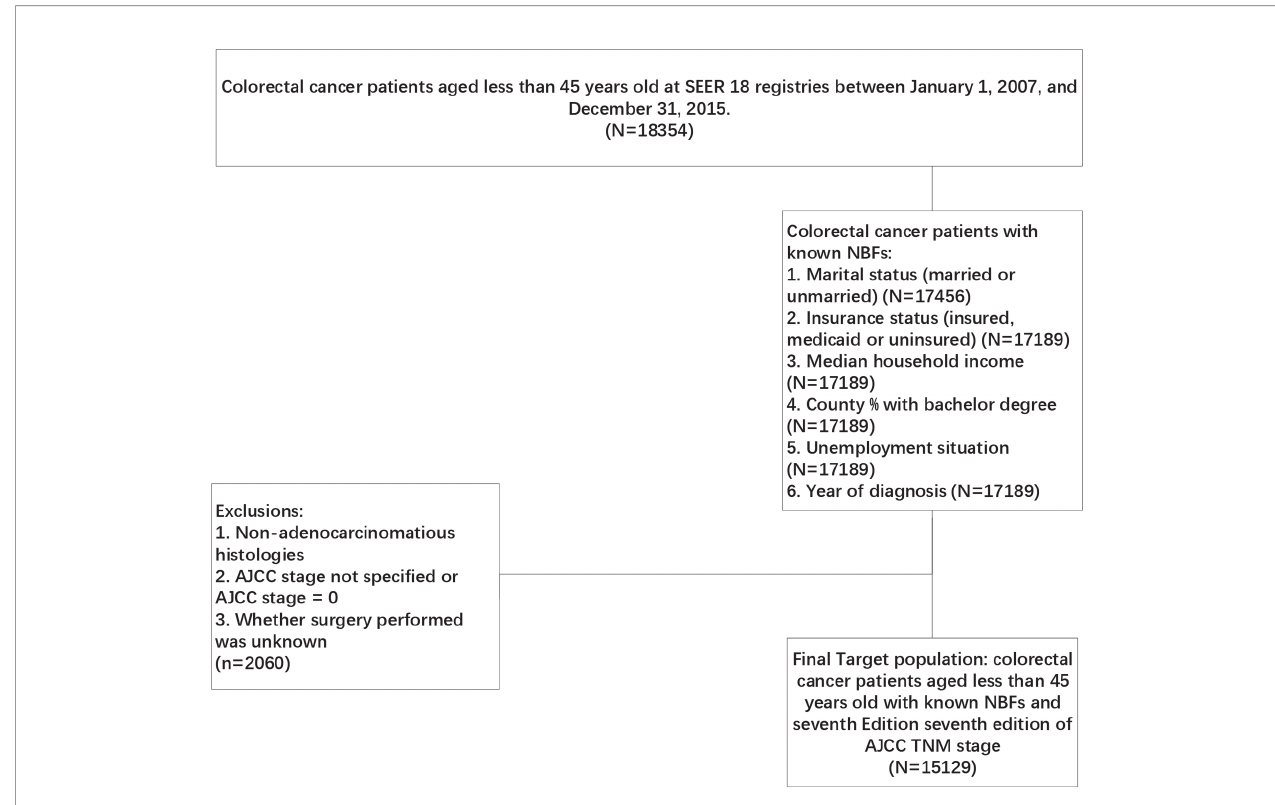
FIGURE 1 | Flow diagram of patient